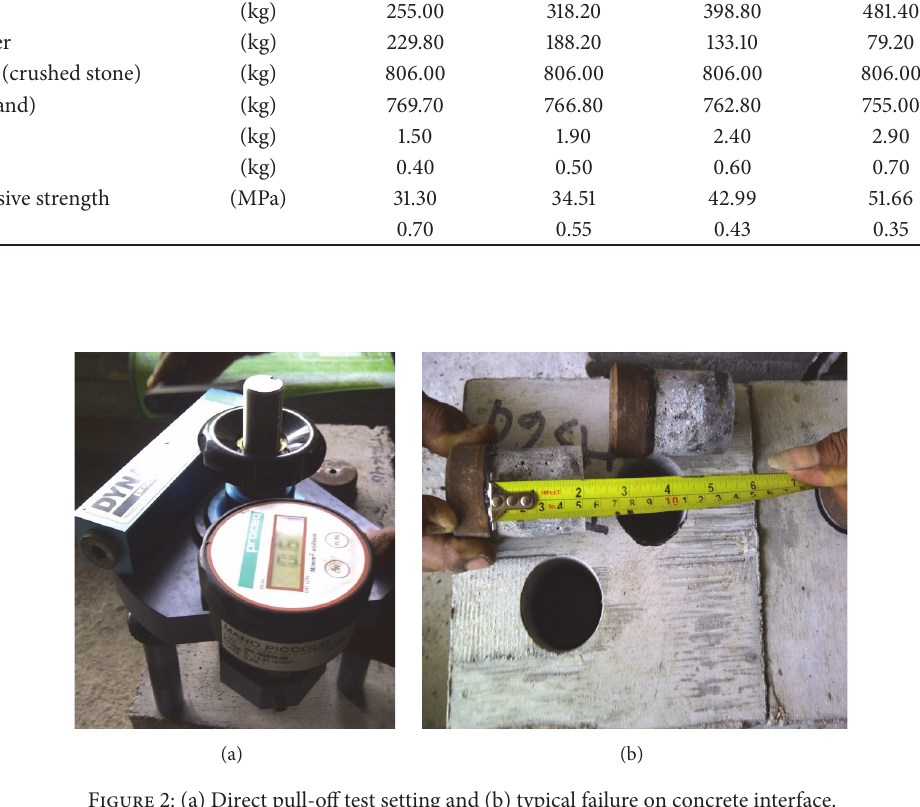
Figure 2: (a) Direct pull-off test setting and (b) typical failure on concrete interface.